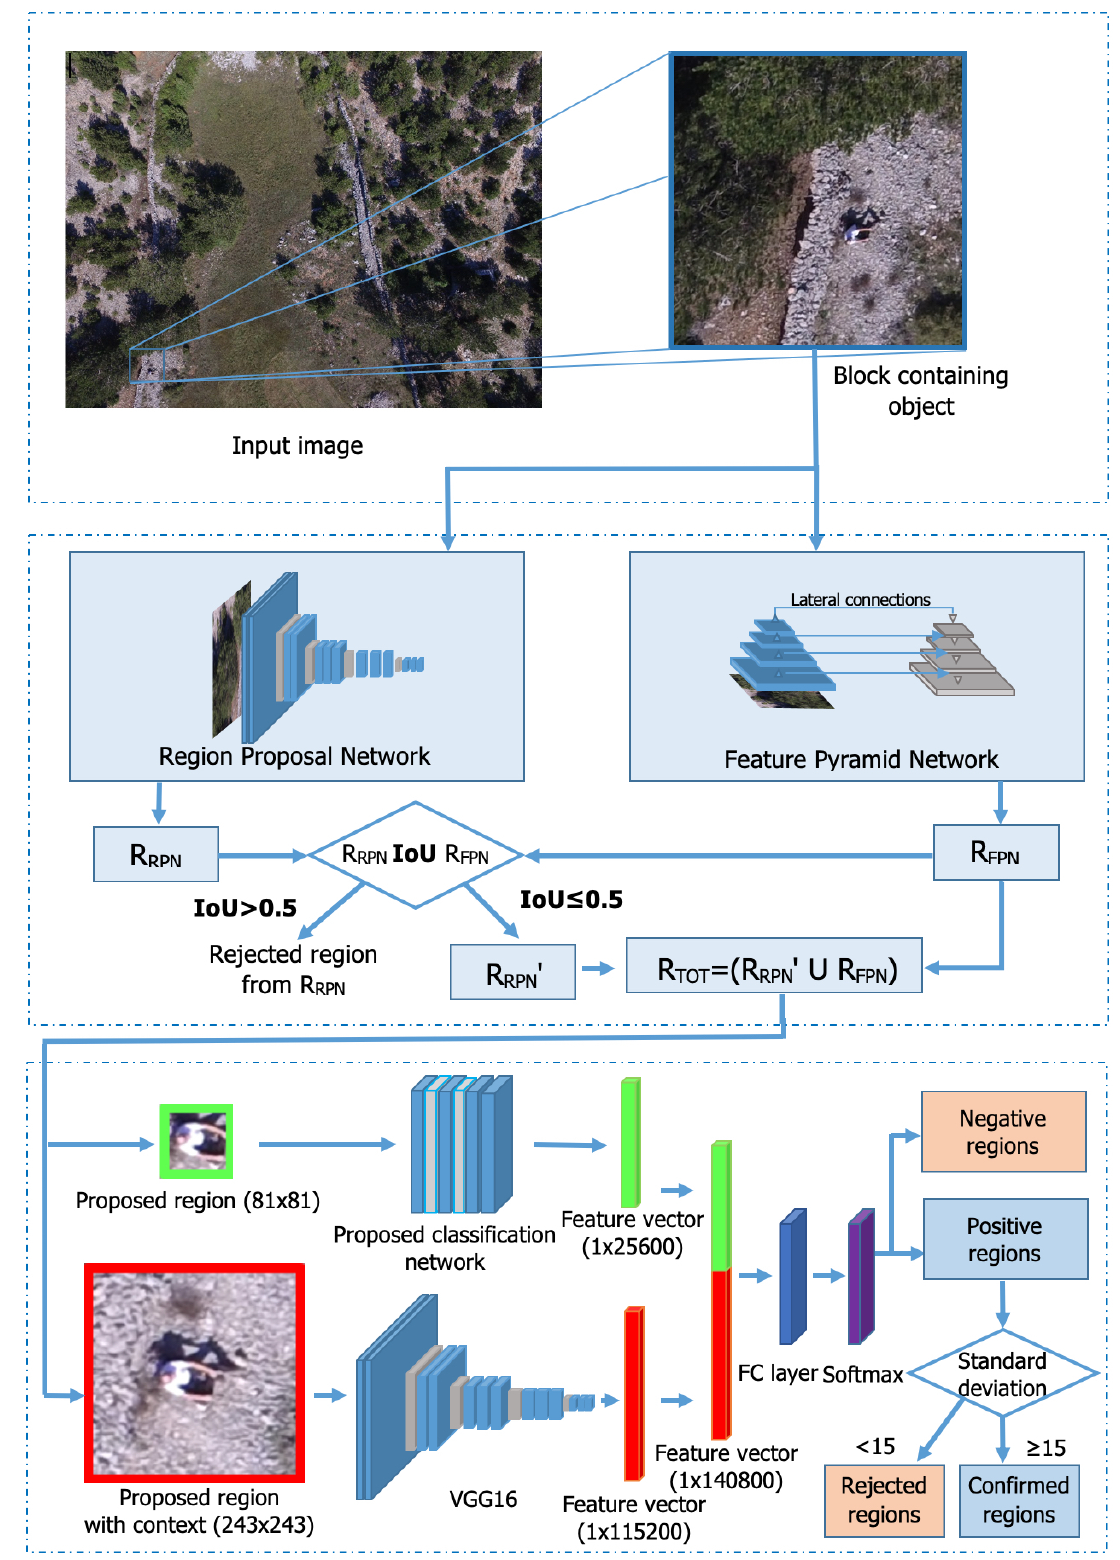
Figure 2. Multimodel approach for person detection in aerial